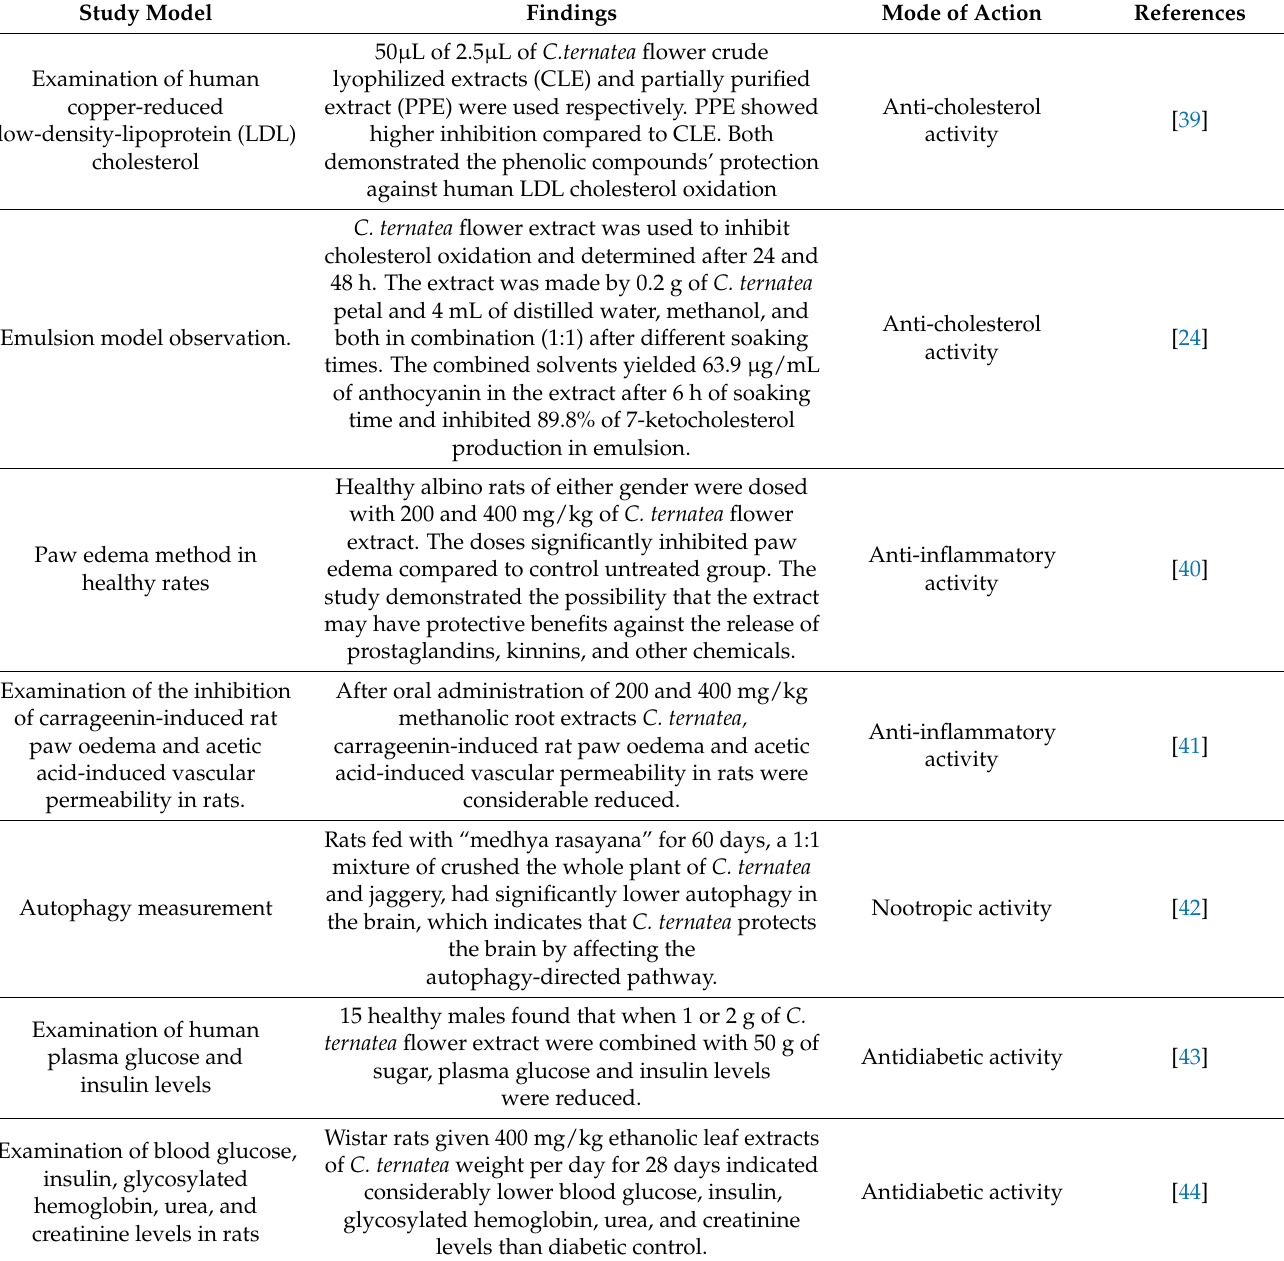
Table 3. Health benefits of C. ternatea